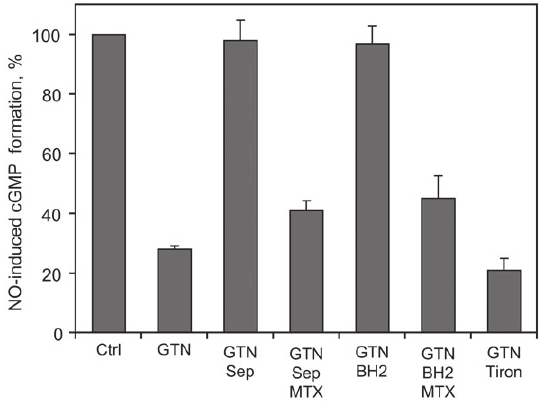
Figure 1 Effects of pteridines on oxidative inactivation of sGC induced by